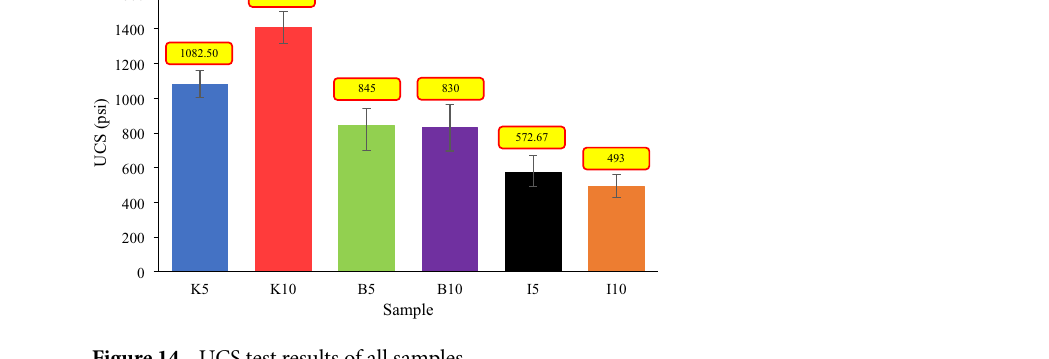
Figure 14. UCS test results of all samples.